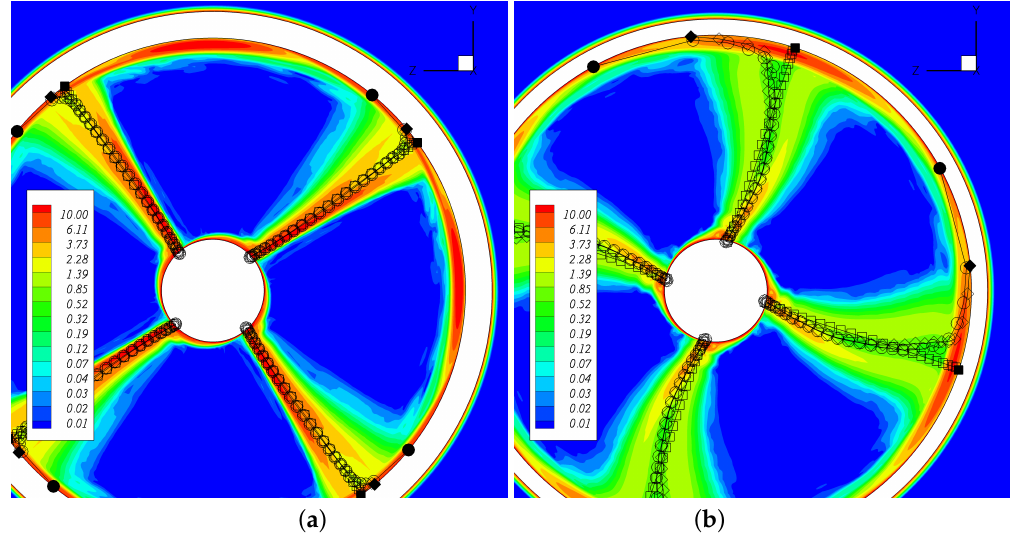
Figure 10. Wake geometry at x / R = 0.2 ( a ) and x / R = 0.4 ( b ) for J = 0.2. The contours represent the ReFRESCO total vorticity field | (cid:126) ω | / Ω . The symbols represent the PROPAN wake geometry: rigid wake model (squares), wake alignment model (diamonds) and wake alignment model with reduced gap pitch (circles). The filled symbols refer to the tip vortex.